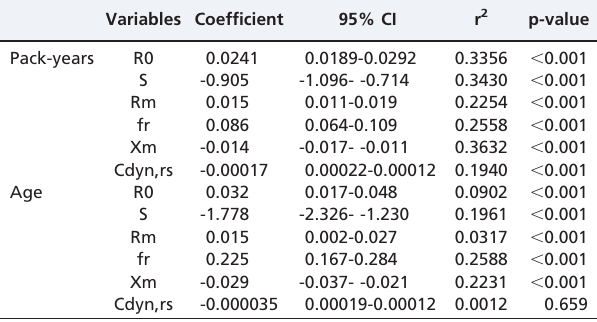
Table 2 - Univariate regressions for respiratory impedance variables based on pack-years and age.